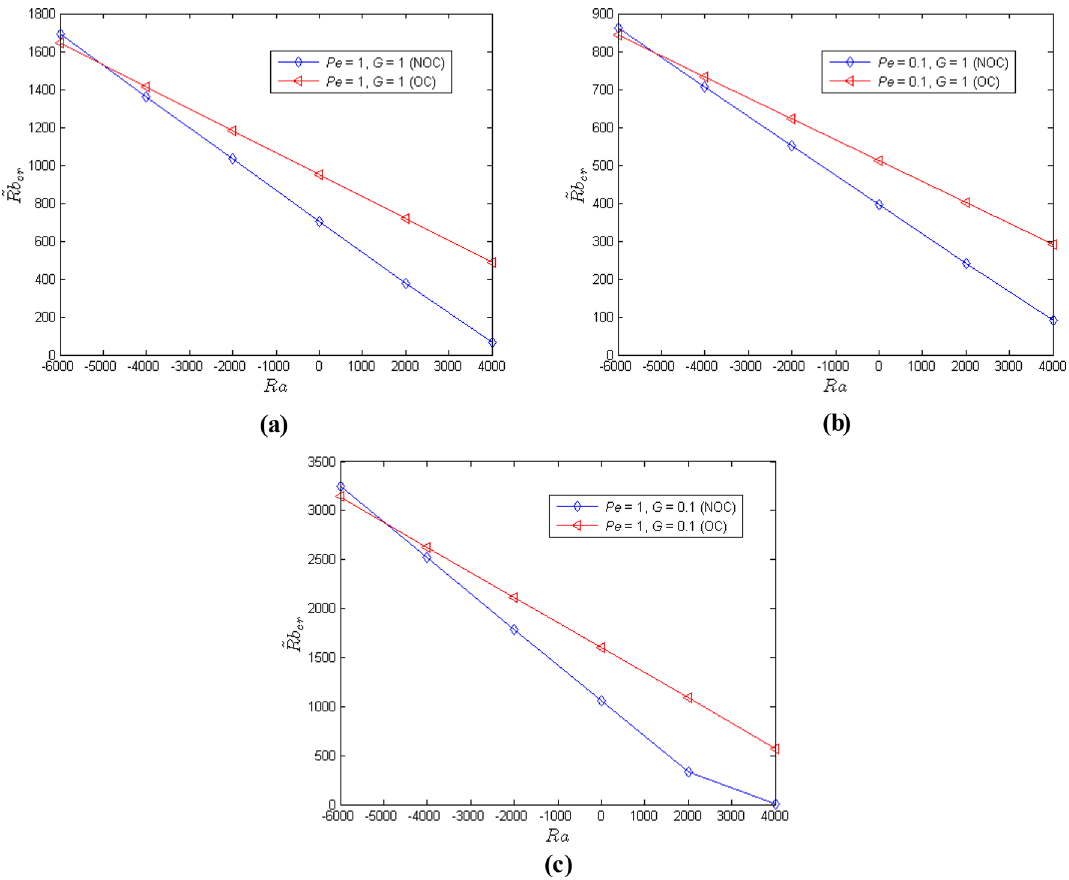
Fig. 1 The case of rigid upper and lower surfaces: a – c Boundaries of Stationary and oscillatory instability modes of convections in the ̃ Rb ( Ra , cr ) plane for the distinct values of Péclet number